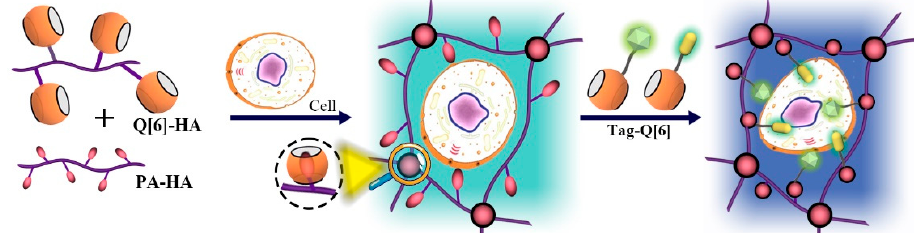
Figure 4. Schematic diagram of the in situ formation of supramolecular biocompatible hydrogels via the host–guest interaction between Q6 and DAH or PA.